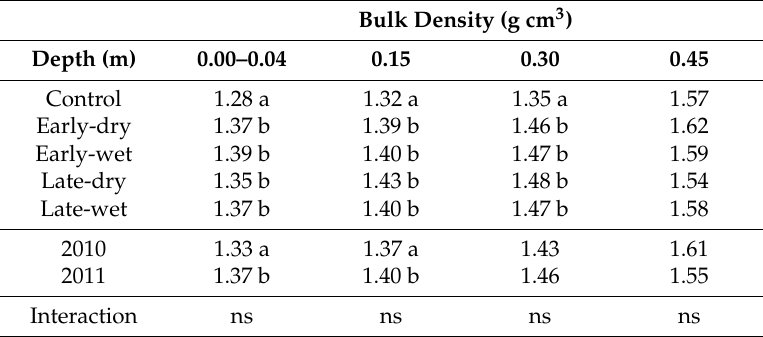
Table 7. Effect of treatment and year on bulk density at four soil